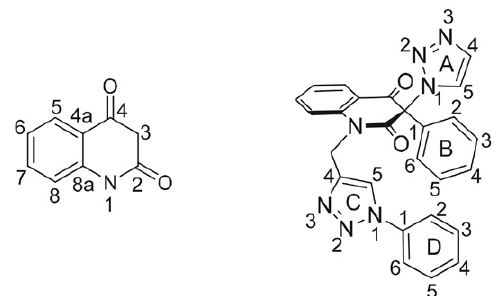
Figure 2. Designation of positions in the structure of prepared com-